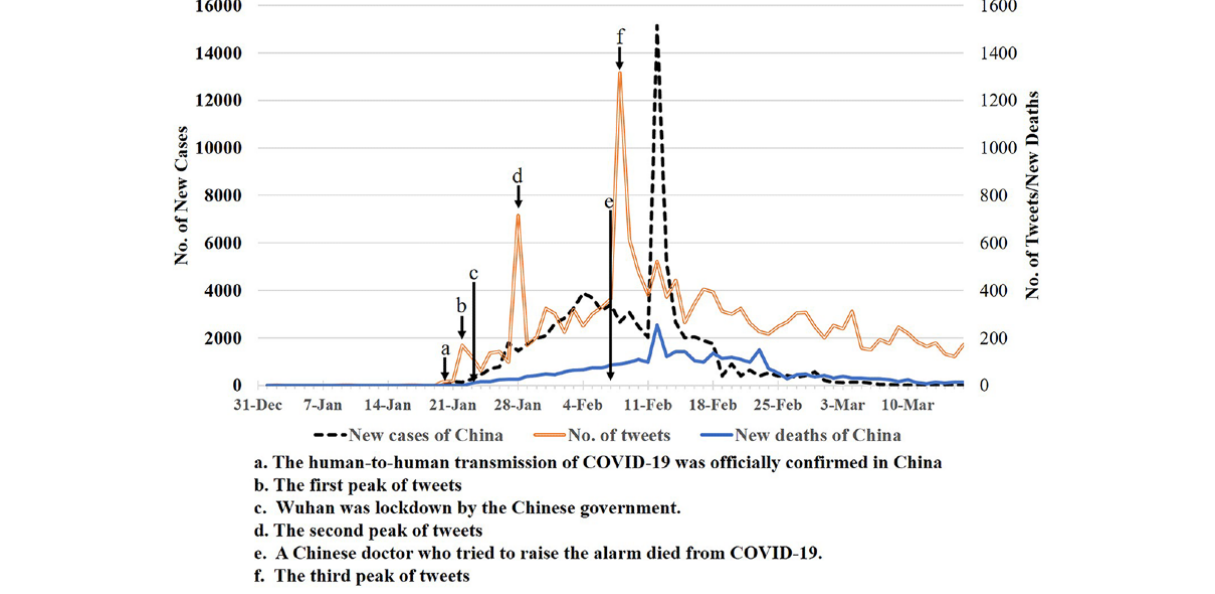
Figure 2. Time distribution of tweets and new cases and deaths of COVID-19 in China. COVID-19: coronavirus